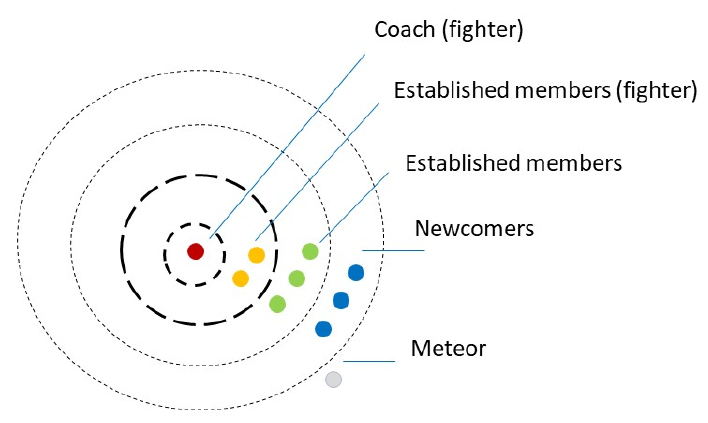
Figure 1. The (ideal) team structure of one boxe popolare class.